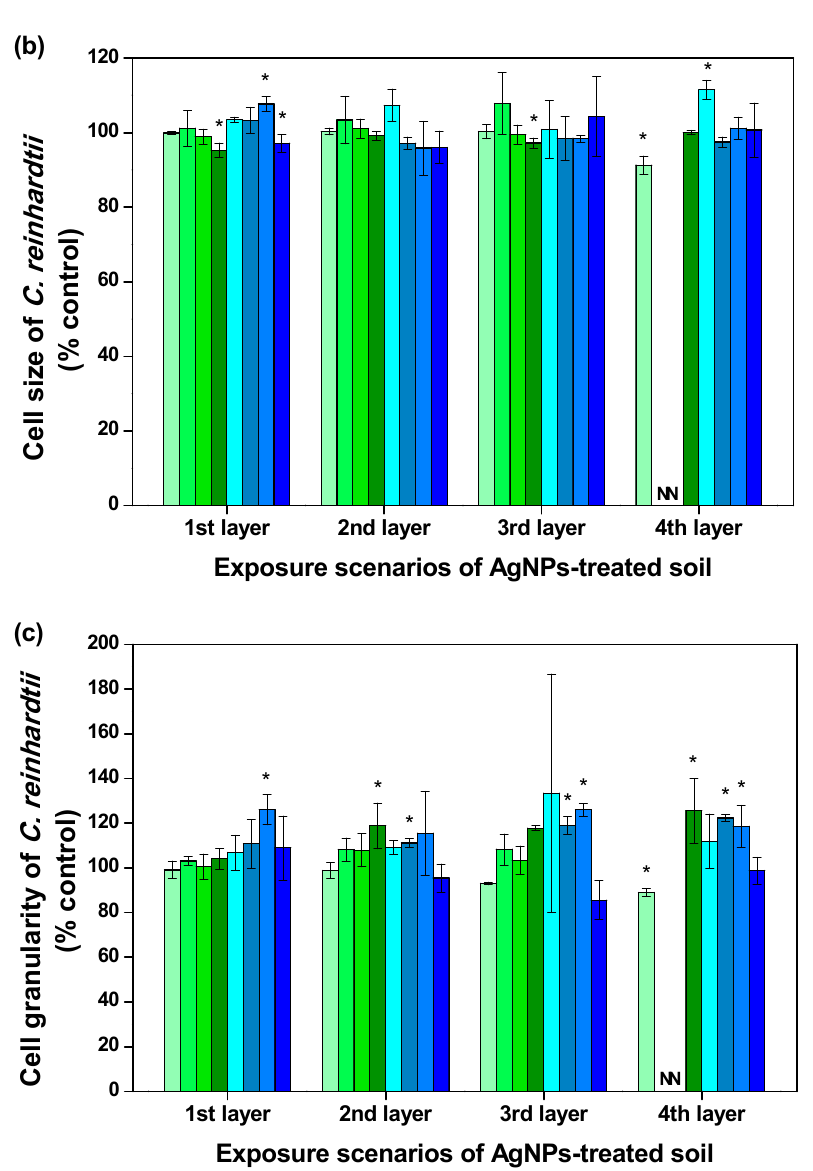
Figure 3. Biomass and cell morphology of Chlamydomonas reinhardtii dependent on the time and contamination configuration in soil treated with silver nanoparticles (AgNPs). ( a ) Biomass, ( b ) cell size, and ( c ) cell granularity. Asterisks (*) represent results that are significantly different from the control ( p < 0.05). N stands for “not applicable” due to low cell density.